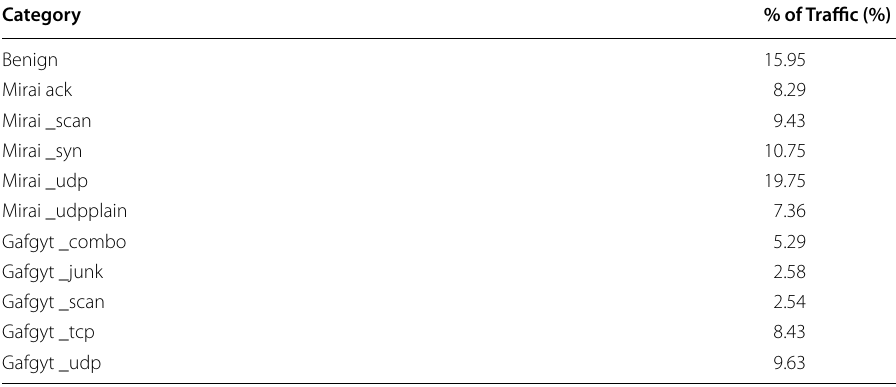
Table 6 % of Benign and Attack Traffic in UNSW-NB17_Philips